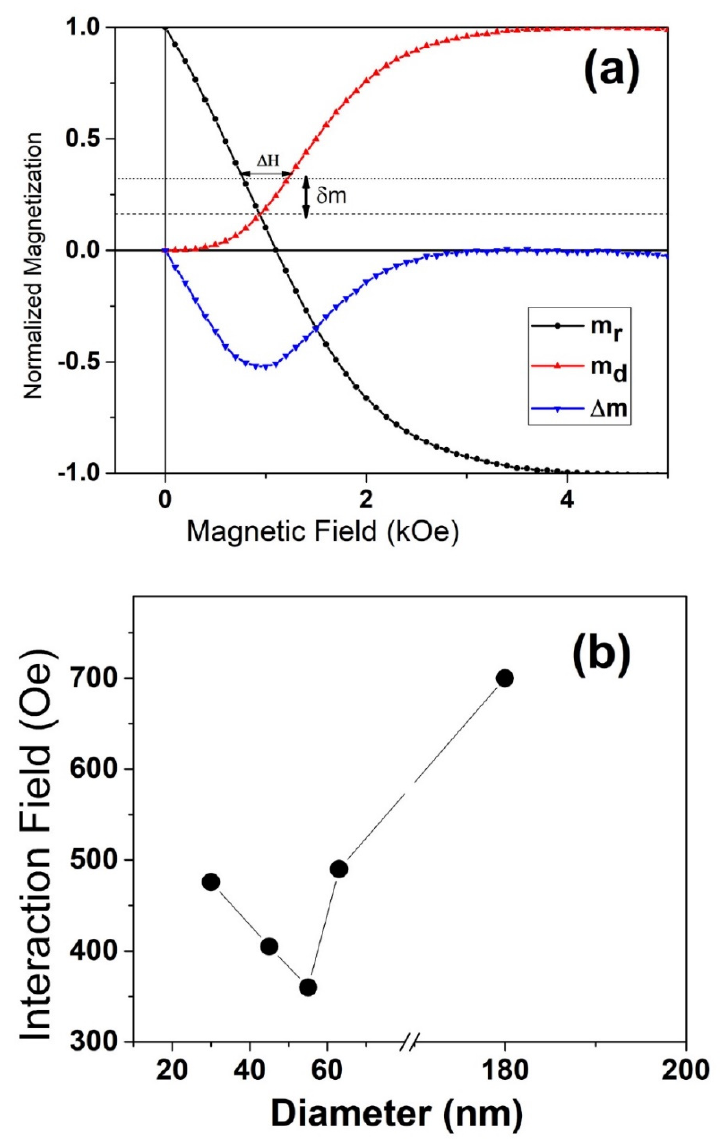
Figure 6. ( a ) m r and m d curves with the field-reflected DCD m d ( H ), and ( b ) estimated interaction field versus interwire spacing.